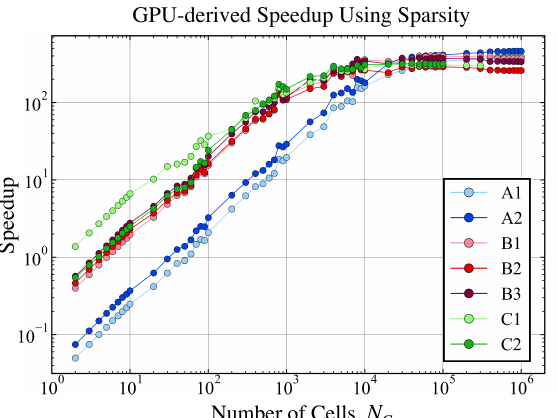
Figure 11. Updated GPU-to-CPU speedup values when taking into account the mechanism sparsity (analogous to Figure